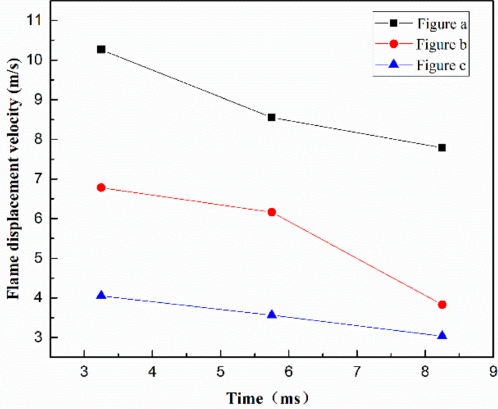
Figure 8. The displacement velocity of flame in autoignition